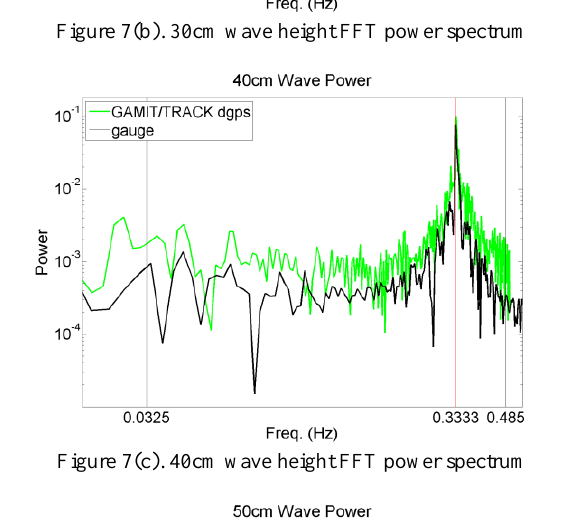
Figure 7(c). 40cm wave height FFT power spectrum